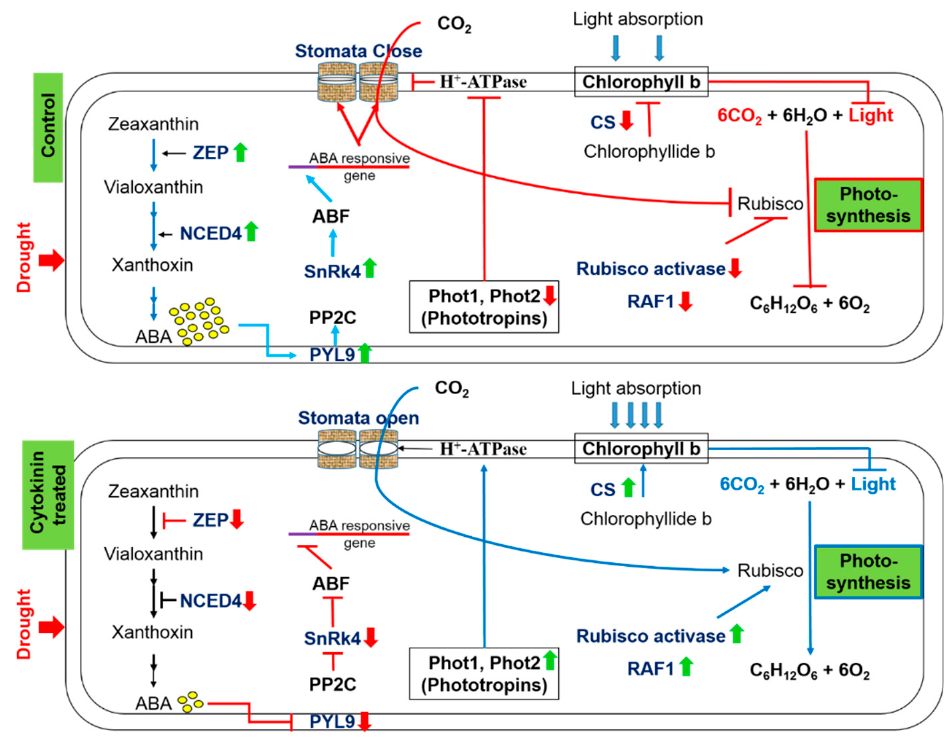
Figure 11. The positive impact of synthetic cytokinin on stomatal conductance, contents of chlorophyll b, and the process of photosynthesis under severe drought stress. Up (green) and down (red) arrows are the symbolic representations of increase and decrease, respectively. ZEP = Zeaxanthin epoxidase, NCED = 9-cis-epoxycarotenoid dioxygenase, ABA = Abscisic acid, PYL9 = Pyrabactin-like receptor 9, PP2C = Protein phosphatase type-2C, SnRK4 = Sucrose non-fermenting-1-related protein kinase 4, ABF = ABA responsive factor, Phot = Phototropin, CS = Chlorophyll synthase, RAF1 = Rubisco accumulation factor 1.